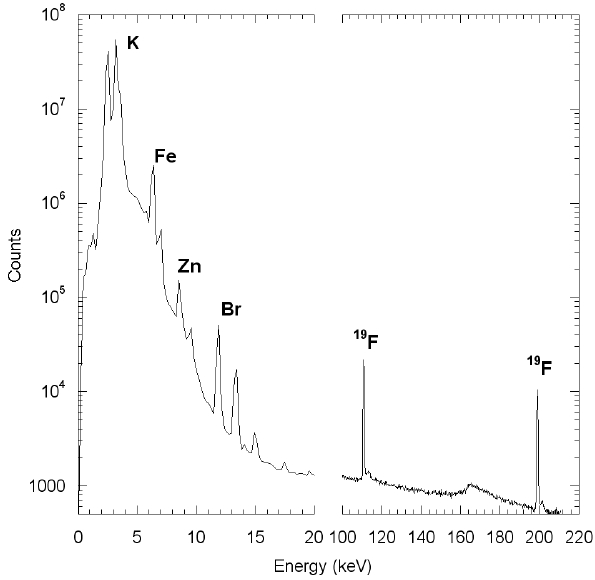
Figure 1. Mean PIXE/PIGE spectrum obtained on biological sample. The counts and respective energies can be sorted according to beam position in order to produce element maps showing gamma or x-ray intensity vs . beam position. Analytical conditions: 3.4 MeV proton beam; intensity 500 pA, beam diameter: 5